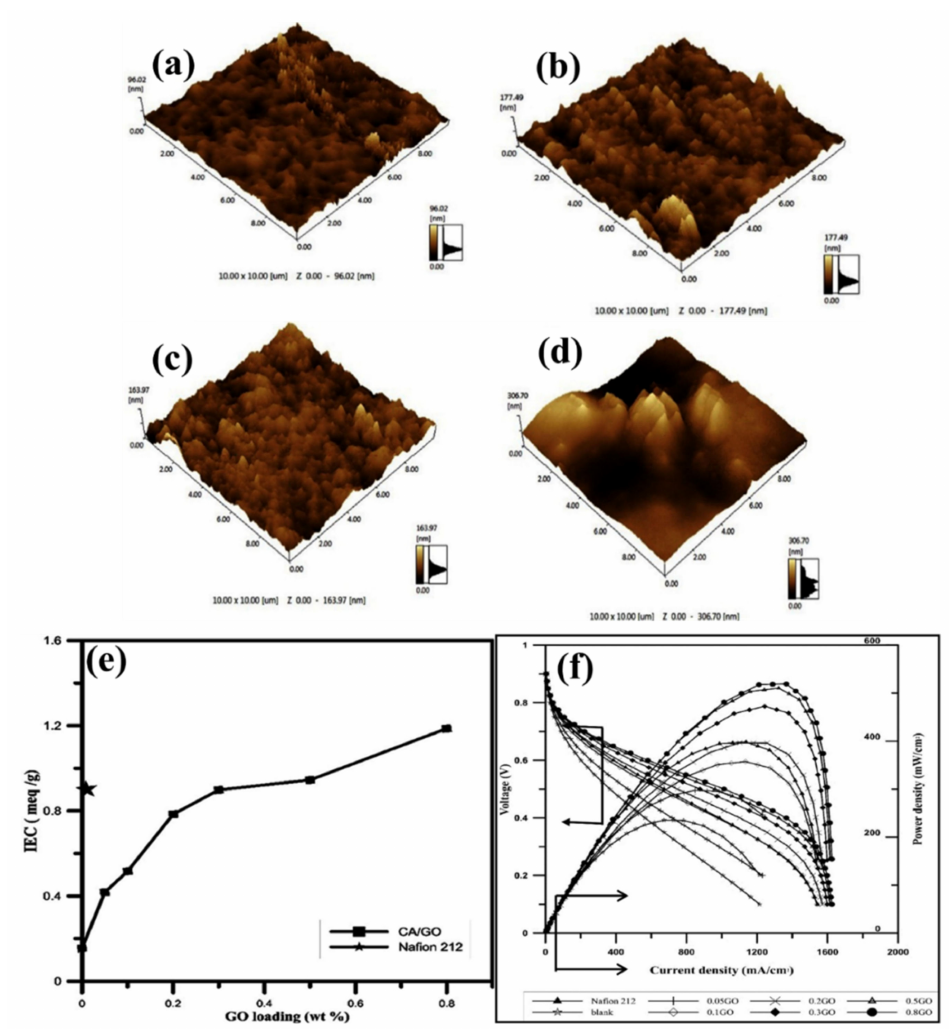
Figure 10. AFM images of cellulose-acetate reinforced graphene oxide nanosheet membrane with different GO content in CA ( a ) GO − 0, ( b ) GO − 0.1, ( c ) GO − 0.3, and ( d ) GO − 0.8. ( e ) IEC and ( f ) PEMFC performance of CA-GO membrane concerning the addition of GO with CA. Reprinted with permission from Ref. [128]. Copyright © 2022 The Authors. Published by Elsevier B.V. on behalf of King Saud University. (License Number: